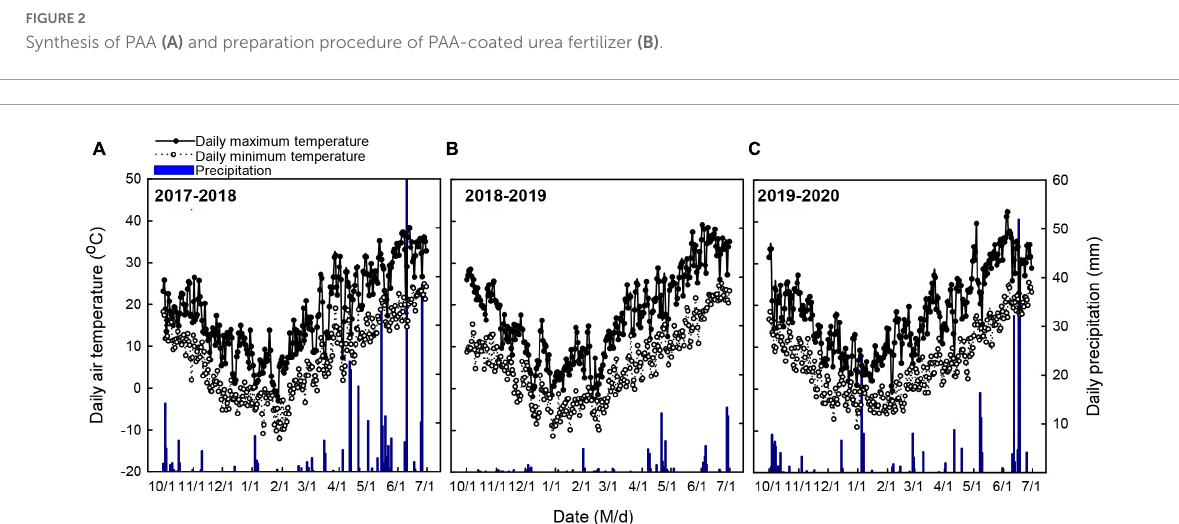
FIGURE3 Daily maximum air temperature, daily minimum air temperature, and daily cumulative precipitation during the 2017–2018 (A) , 2018–2019 (B) , and 2019–2020 (C) winter wheat growing